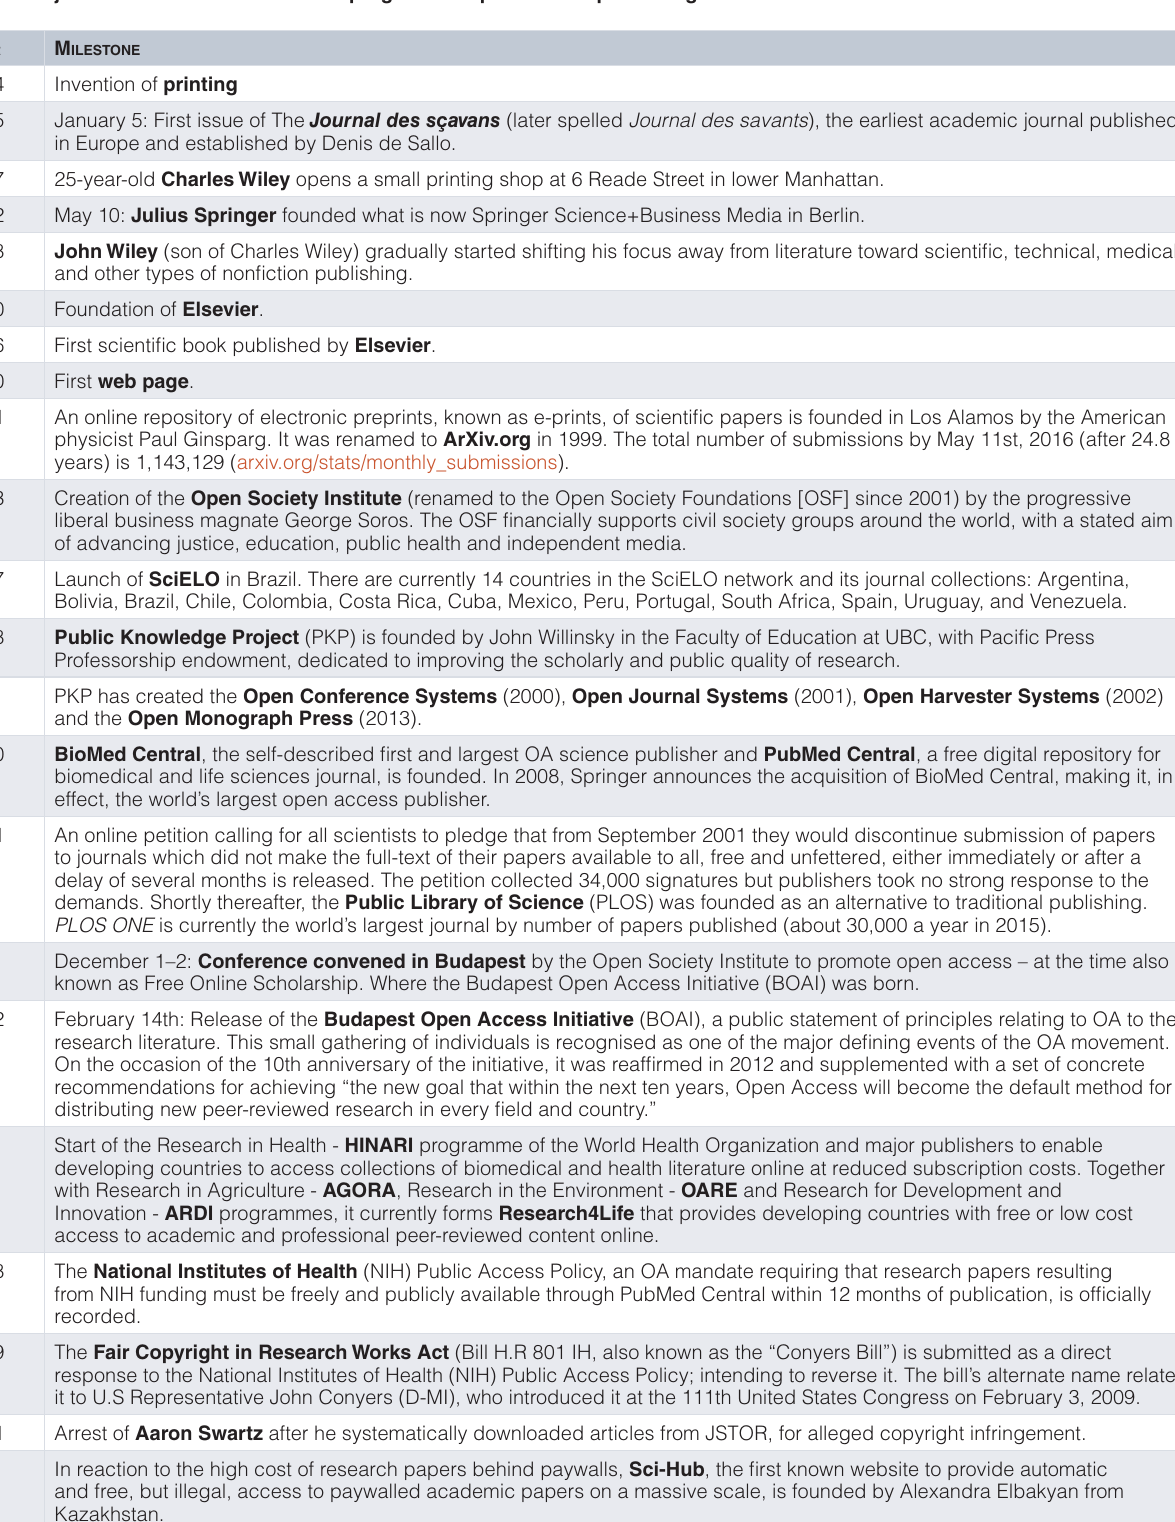
Table 1. Major historical milestones in the progress of Open Access